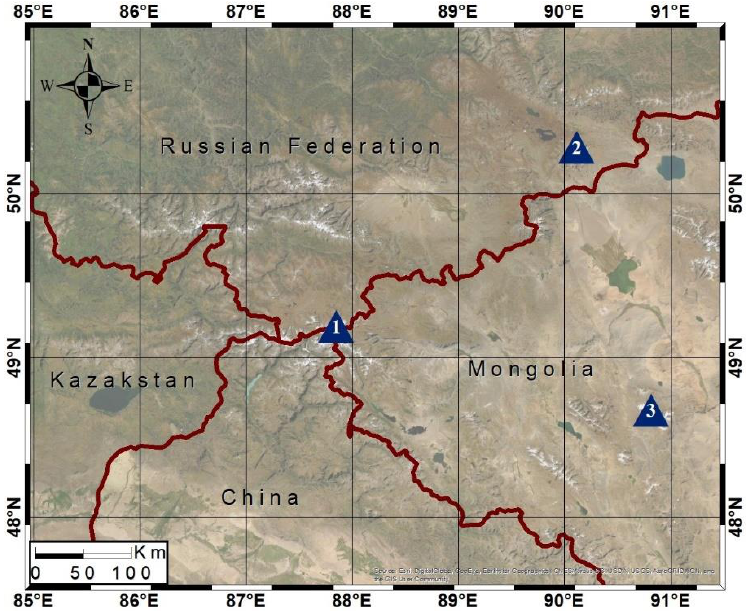
Figure 1. Sampling areas: 1 — Tavan-Bogd; 2 — Mongun-Taiga; 3 —